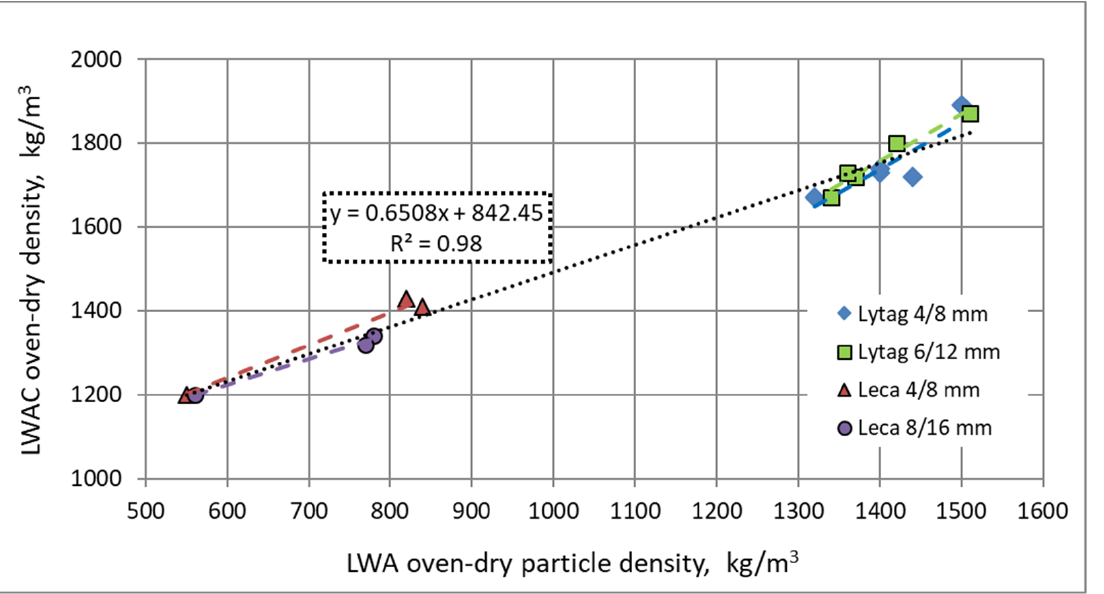
Figure 8. Relationship between mean oven-dry particle density of aggregates and mean oven-dry density of composites.